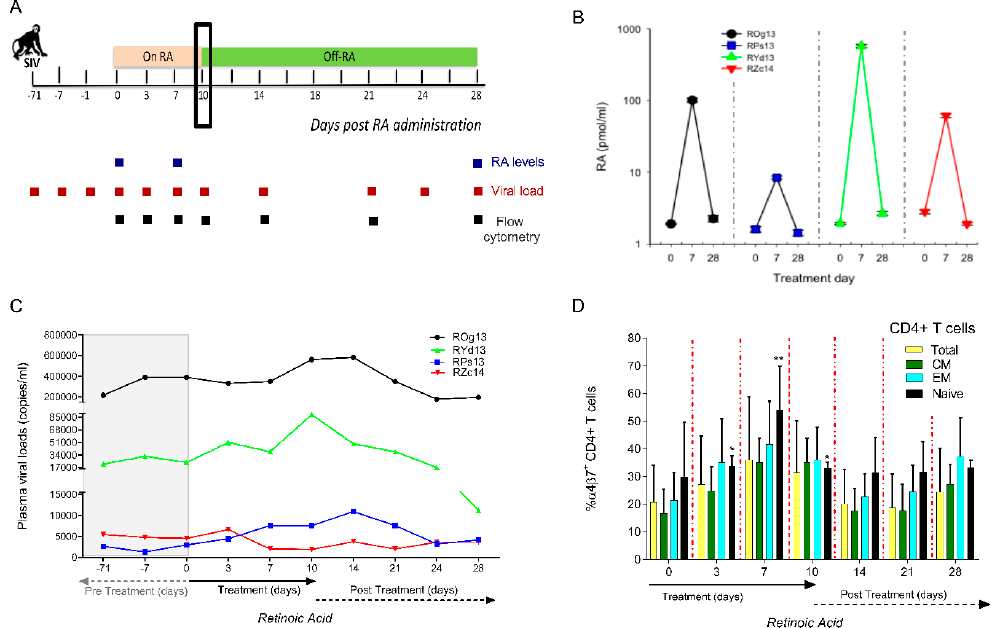
Figure 2. Administration of RA affects SIV replication kinetics by causing modest increases in peripheral SIV replication and the expansion of naive CD4 + T cells ( n = 4 RMs). ( A ) Pictorial